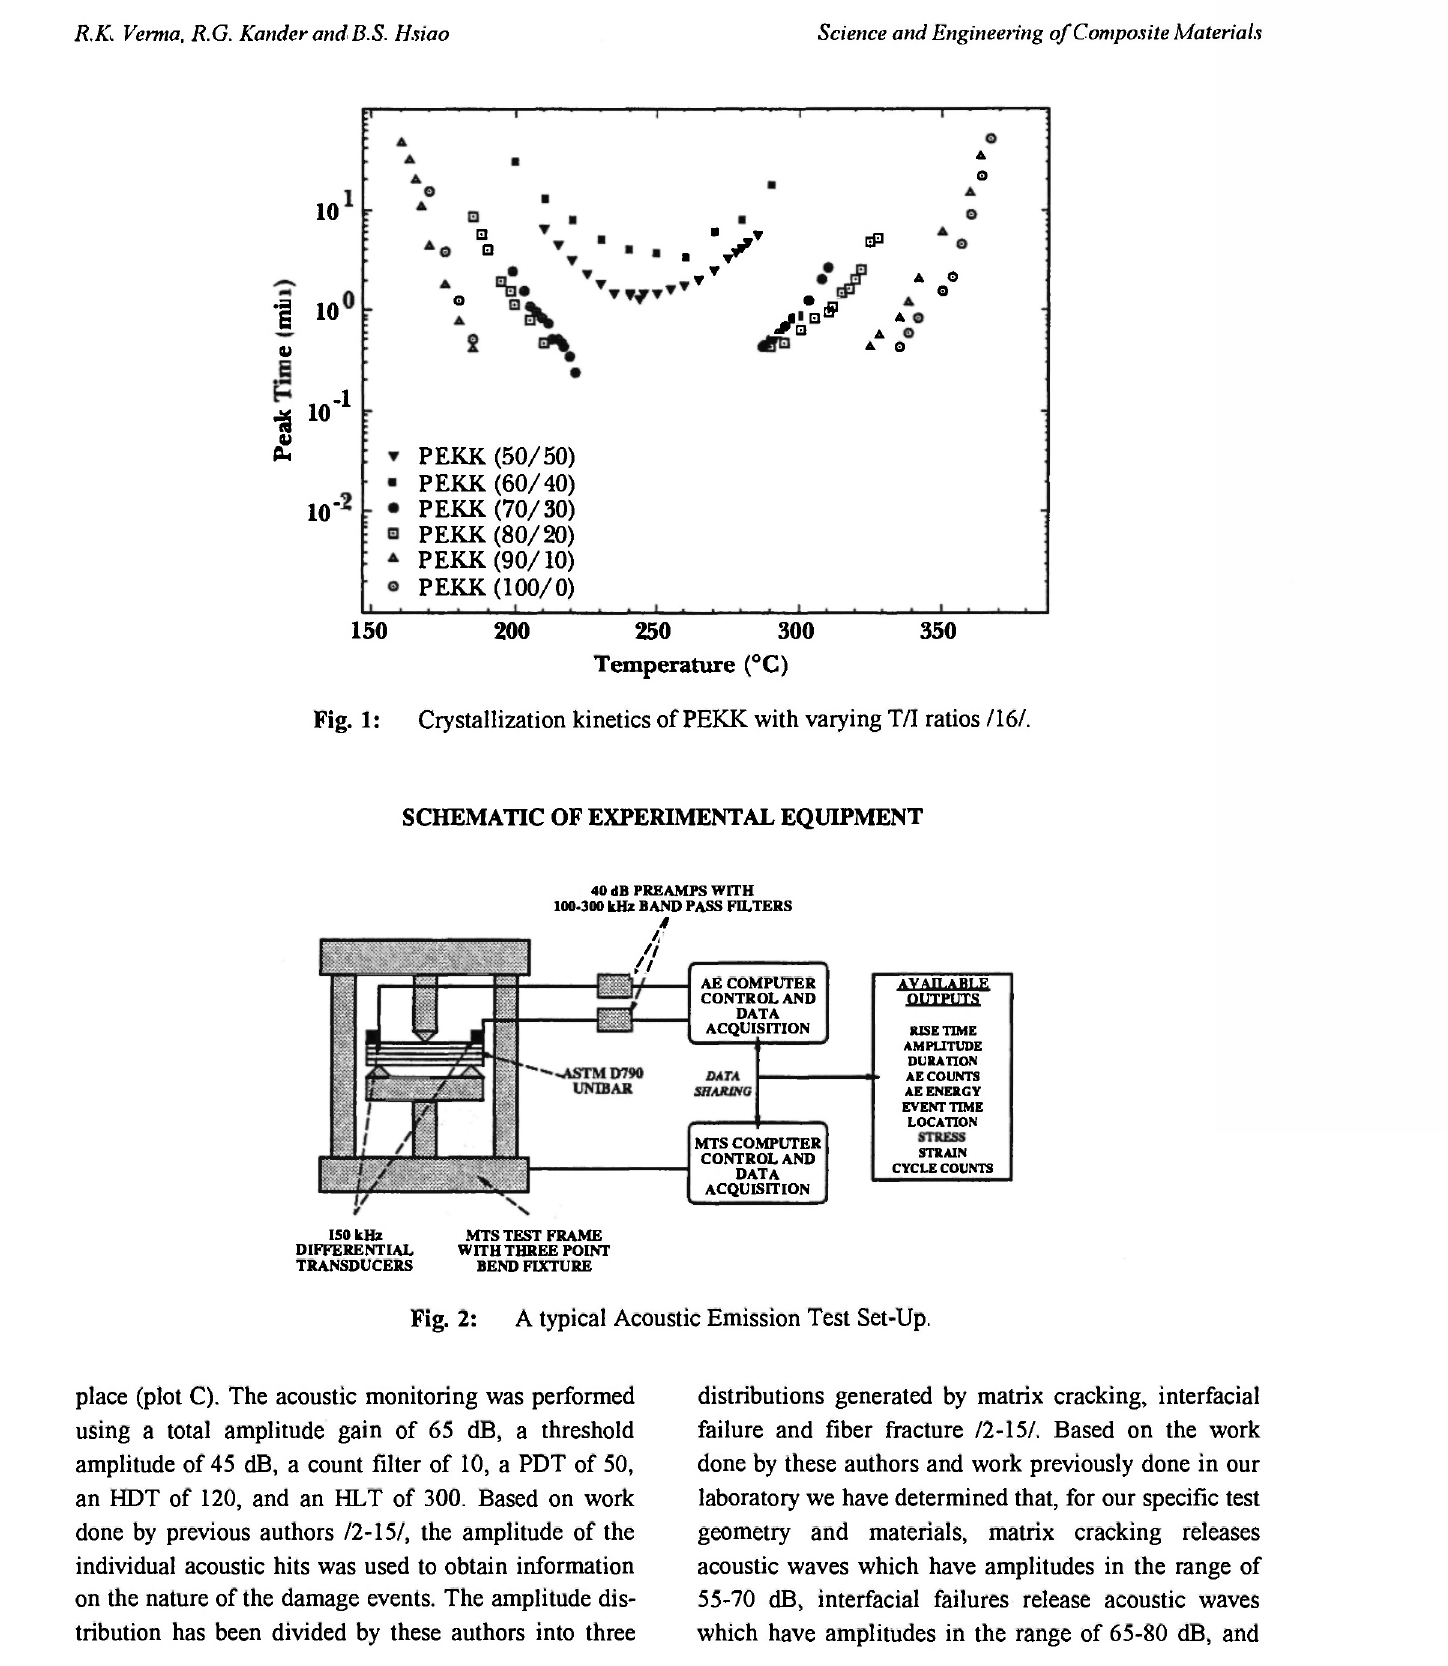
Fig. 2: A typical Acoustic Emission Test